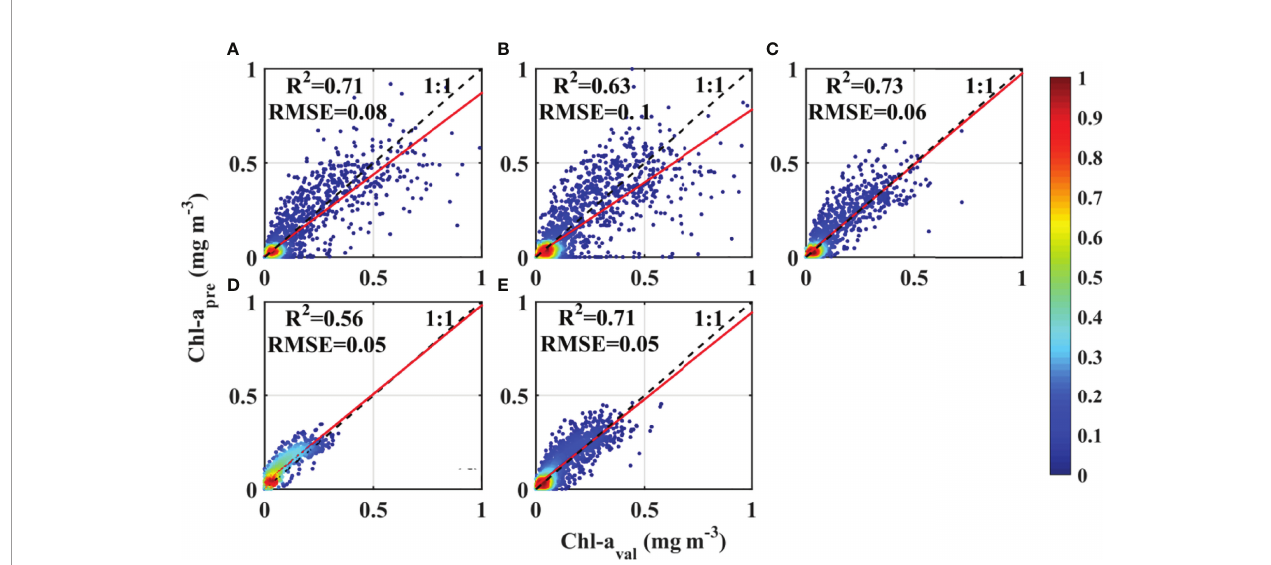
FIGURE 11 | Scatterplots of the in situ Chl-a concentrations at different depths and those reconstructed via the method proposed in this study. Panels (A-E) successively show the comparisons for the SW, NW, TYR, ION and LEV subsea areas.